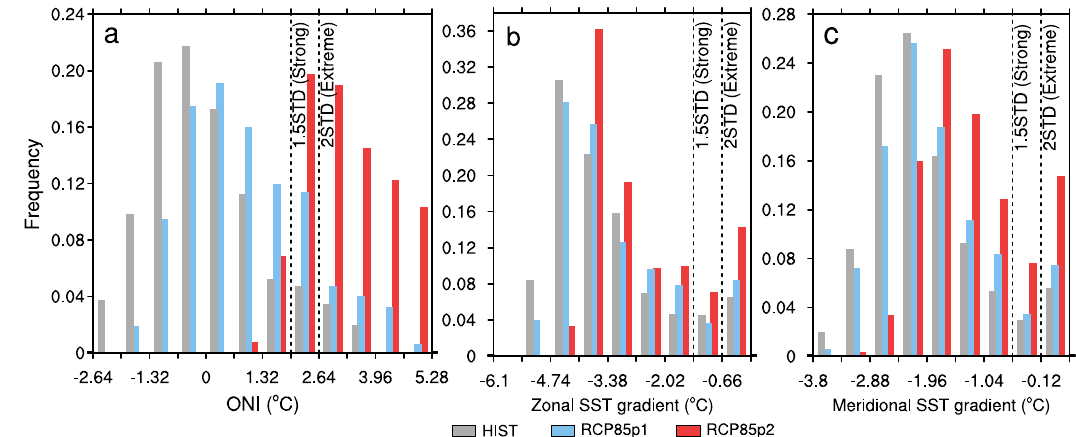
Fig. 6 | Histograms of El Nin ̃ o indices associated with greenhouse warming experiments.a TheOceanicNin ̃ oIndex, b thezonalsea-surfacetemperature ( SST) gradientintheequatorialPaci fi c,and c themeridionalSSTgradient.Gray,blue,and red bars are the historical simulation during 1980 – 1999 (HIST), the greenhouse